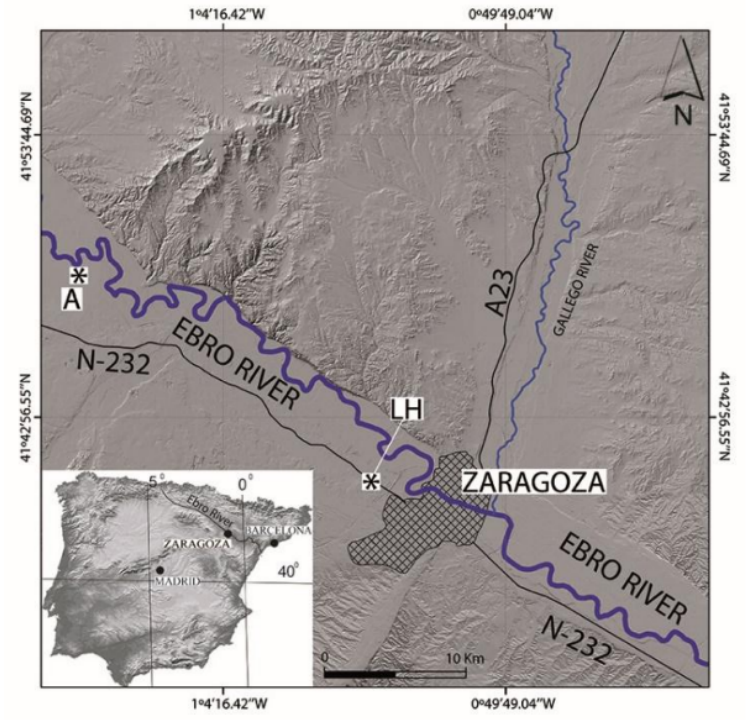
Figure 1. Geographical distribution of the investigated sinkholes (A: Alcal á ; LH: Logroño highway) within the middle reach of the Ebro River valley, NE